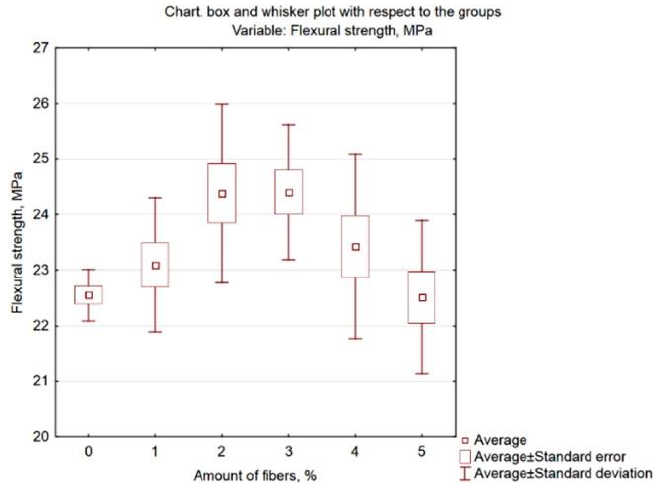
Figure 7. Box and whisker plot of flexural strength related to fibre content.